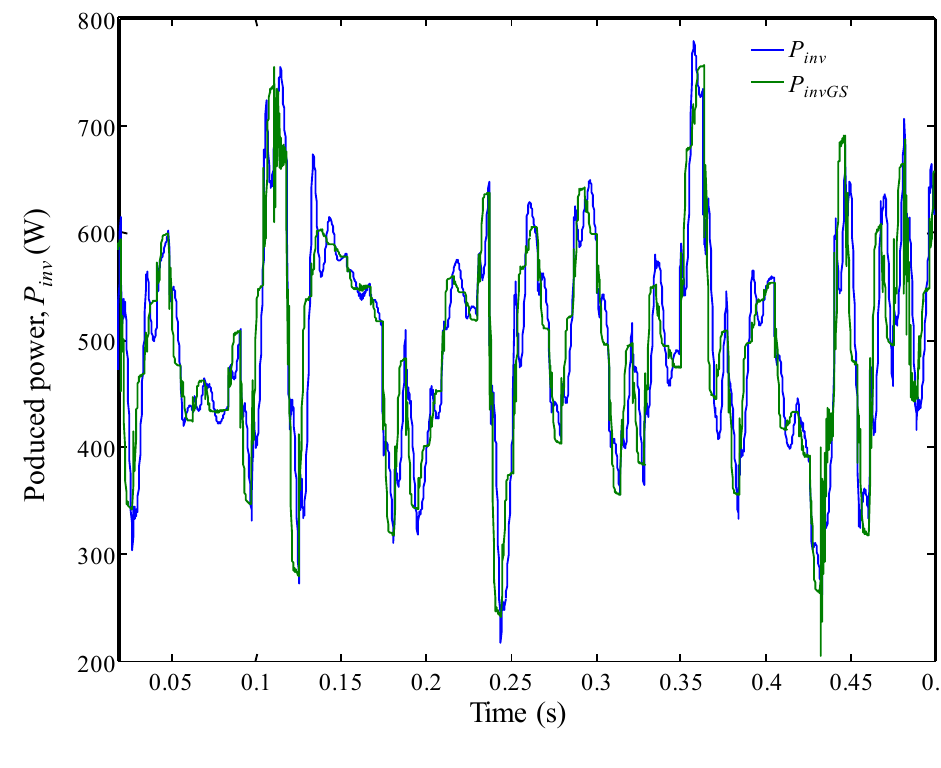
Figure 18. Active power produced by the inverter with the two different controllers in the presence of a current disturbance corresponding to